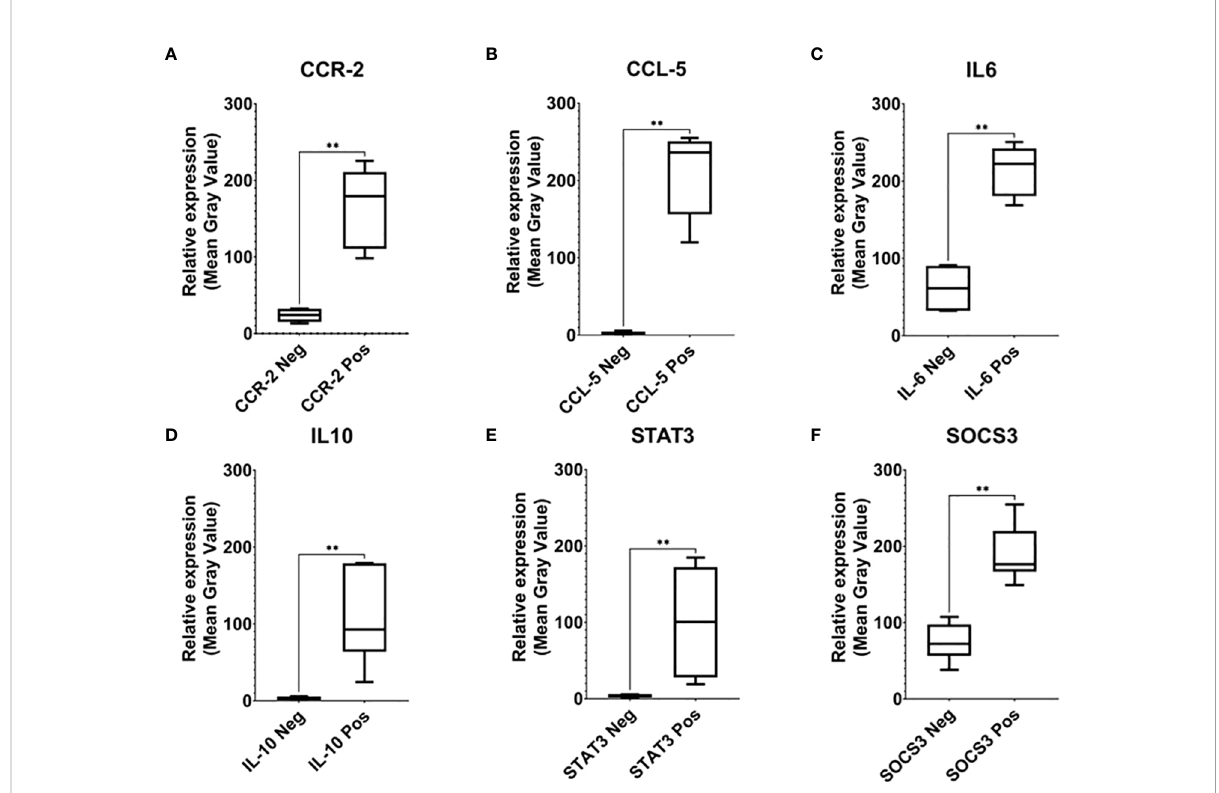
FIGURE 2 Relative expression analysis of CCR-2 (A) , CCR-5 (B) , IL-6 (C) , IL-10 (D) , STAT3 (E) , and SOCS-3 (F) . To con fi rm the speci fi city of the expression pattern, we further compared the strongly expressed area with the uninfected area in the same biopsy tissue (neg). The expression pattern of those markers was signi fi cantly higher than the negative area, which indicates signal speci fi city (** indicated 0.001 ≤ P <